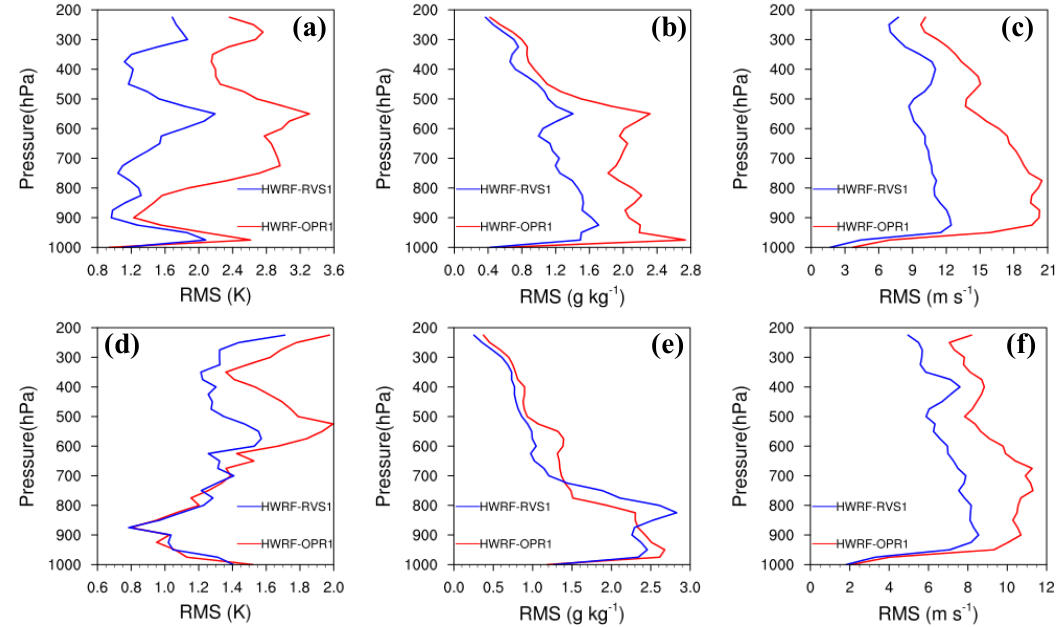
Figure 8. The RMS fit of the forecasts to the dropsonde observations for (left) temperature (K), (middle) specific humidity (g kg − 1 ) and (right) wind speed (m s − 1 ) as a function of pressure at ( a – c ) 24-h and ( d – f ) 48-h forecast lead times for the experiments of HWRF-OPR1 (red lines) and HWRF-RVS1 (blue lines).